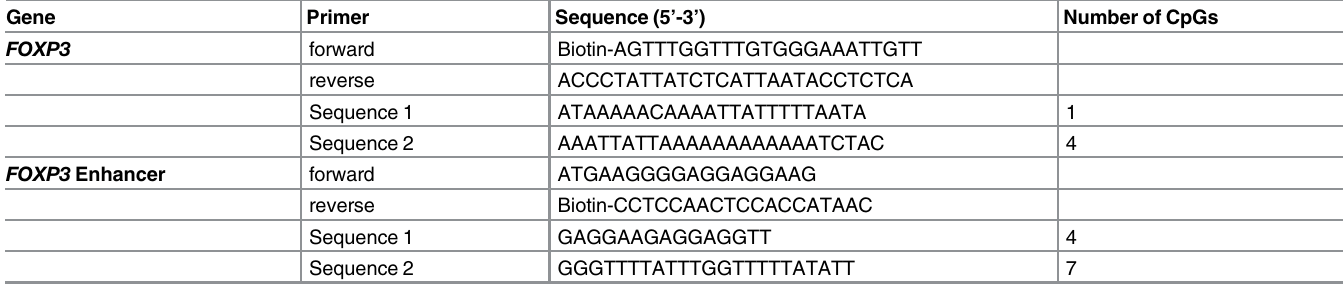
Table 2. Primers used for bisulfite pyrosequencing.